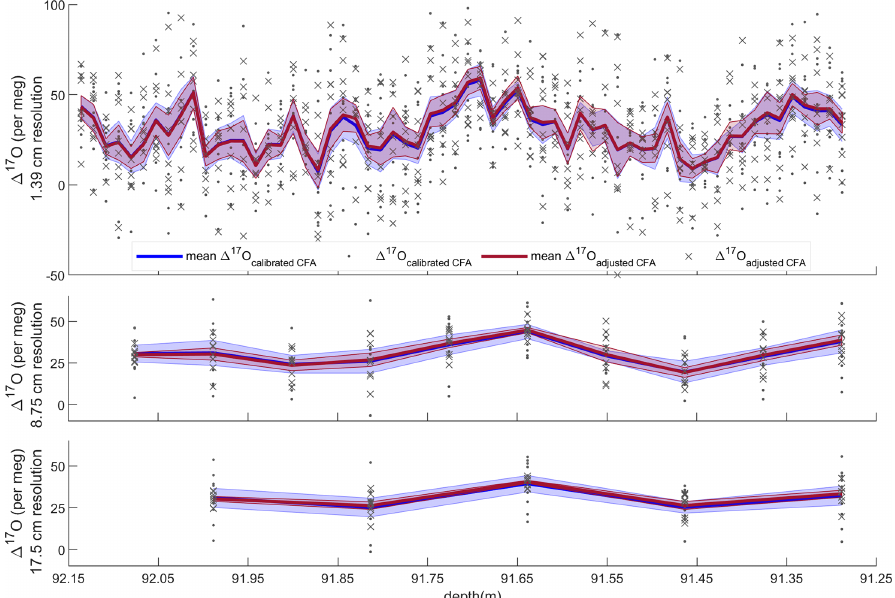
Figure 5. Average (cid:49) 17 O with standard error and all CFA–CRDS measurements, shown for three different depth resolutions. Dots and blue error envelopes indicate (cid:49) 17 O calibratedCFA , and X symbols and red error envelopes indicate (cid:49) 17 O adjustedCFA . All data are plotted at the upper depth of the depth interval that they represent. Note that the upper panel is expanded such that all three vertical scales are identical.